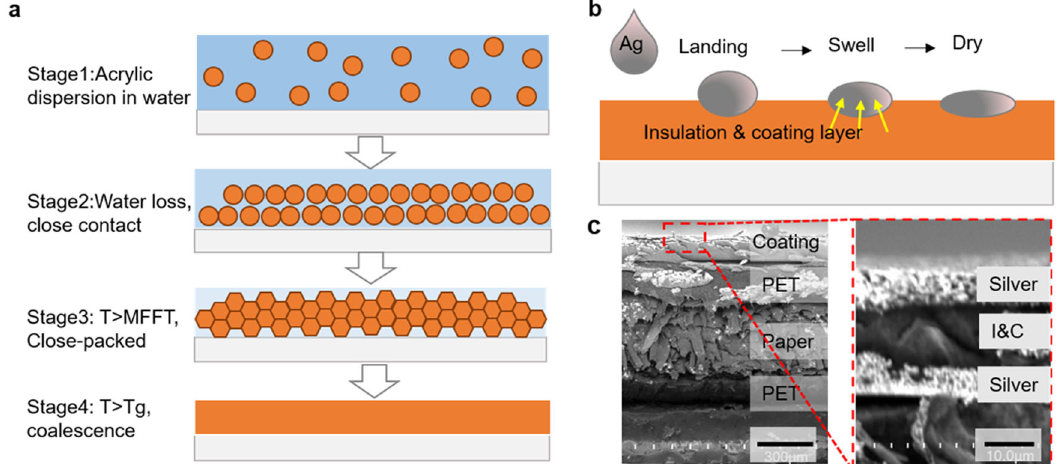
Fig. 2 Microstructure analysis of I&C layer. a Film formation from acrylic dispersions. b Principle of ink absorption on the polymer-type coating layer. c Cross-sectional scanning electron microscopy (SEM) images of the photographic paper and the I&C layer. Scale bars are 90 μ m (left panels) and 30 μ m (right